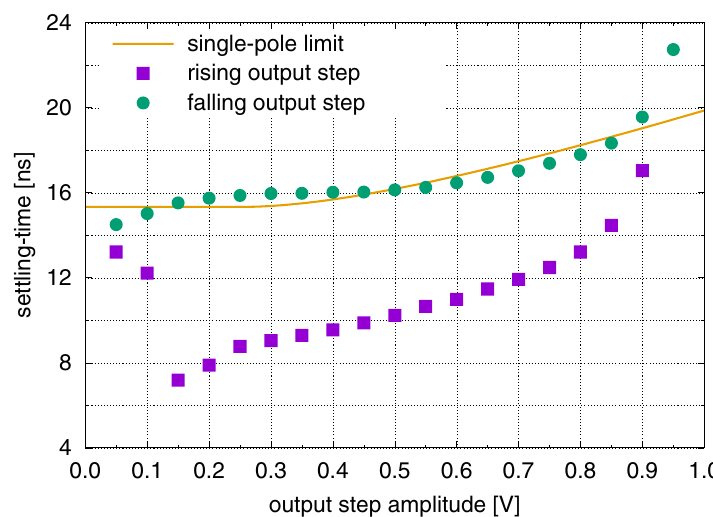
Figure 14. Settling time versus output step amplitude for the closed-loop amplifier compensated with the RNMC-ICBFF. The plot shows also the single-pole limit evaluated using (22) with (9).